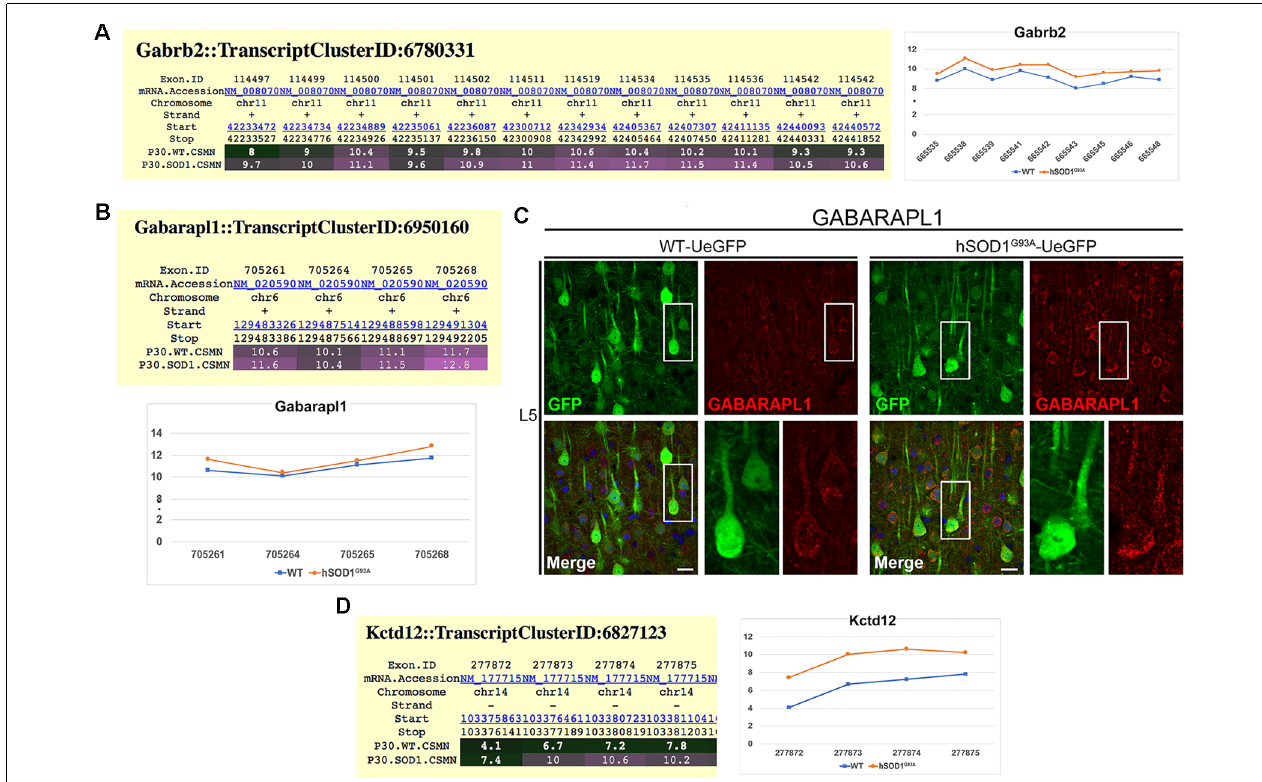
FIGURE 4 | Molecular evidence of altered inhibitory transmission in hSOD1 G93A CSMN. (A) Gene expression analysis of Gabarb2. Expression values for each exon are plotted to the right. (B) Gene expression analysis data for Gabarapl1. Expression values for each exon is plotted at the bottom. (C) Representative images of GABARAPL1 expression in L5 motor cortex of WT-UeGFP (left) and hSOD1 G93A -UeGFP (right). CSMN (green) and GABARAPL1 (red); insets are enlarged in the bottom right panels. Scale bar: 25 µ m. (D) Gene expression analysis of Kctd12. Expression values for each exon are plotted to the